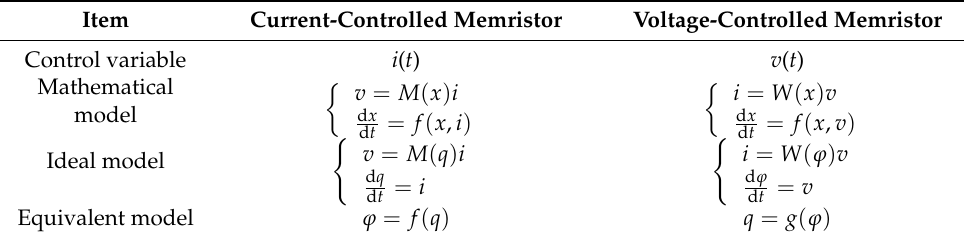
Table 3. Definitions of the